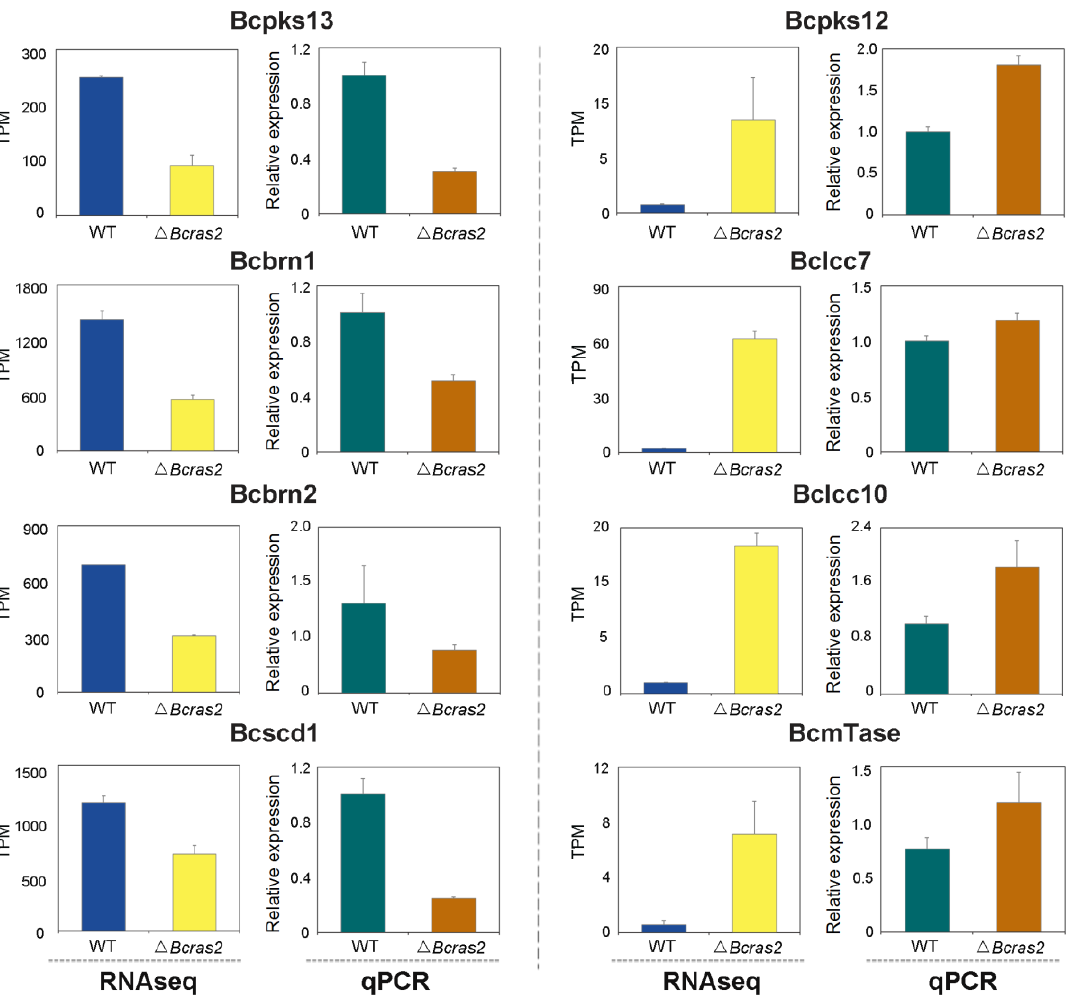
Figure 7. RT-qPCR analysis for differentially expressed genes in RNA sequencing. Bcpks13, Bcpks12: polyketide synthase. Bcbrn1, Bcbrn2: tetrahydroxynaphthalene reductases. Bcscd1: dehydratase. Bclcc7, Bclcc10: laccase. BcmTase: umta methyltransferase.